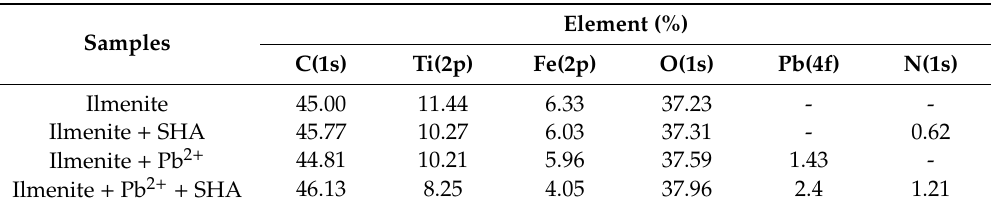
Table 2. Relative atomic concentrations of elements on ilmenite